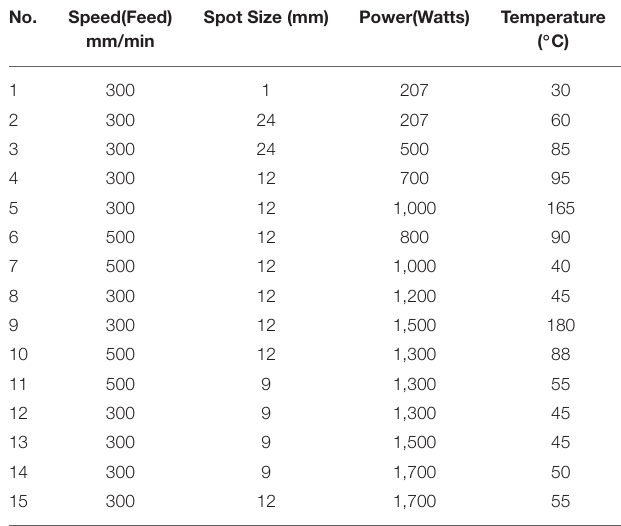
TABLE 4 | Demonstrate the speed, spot size, power, and temperature for each line in Figure 7